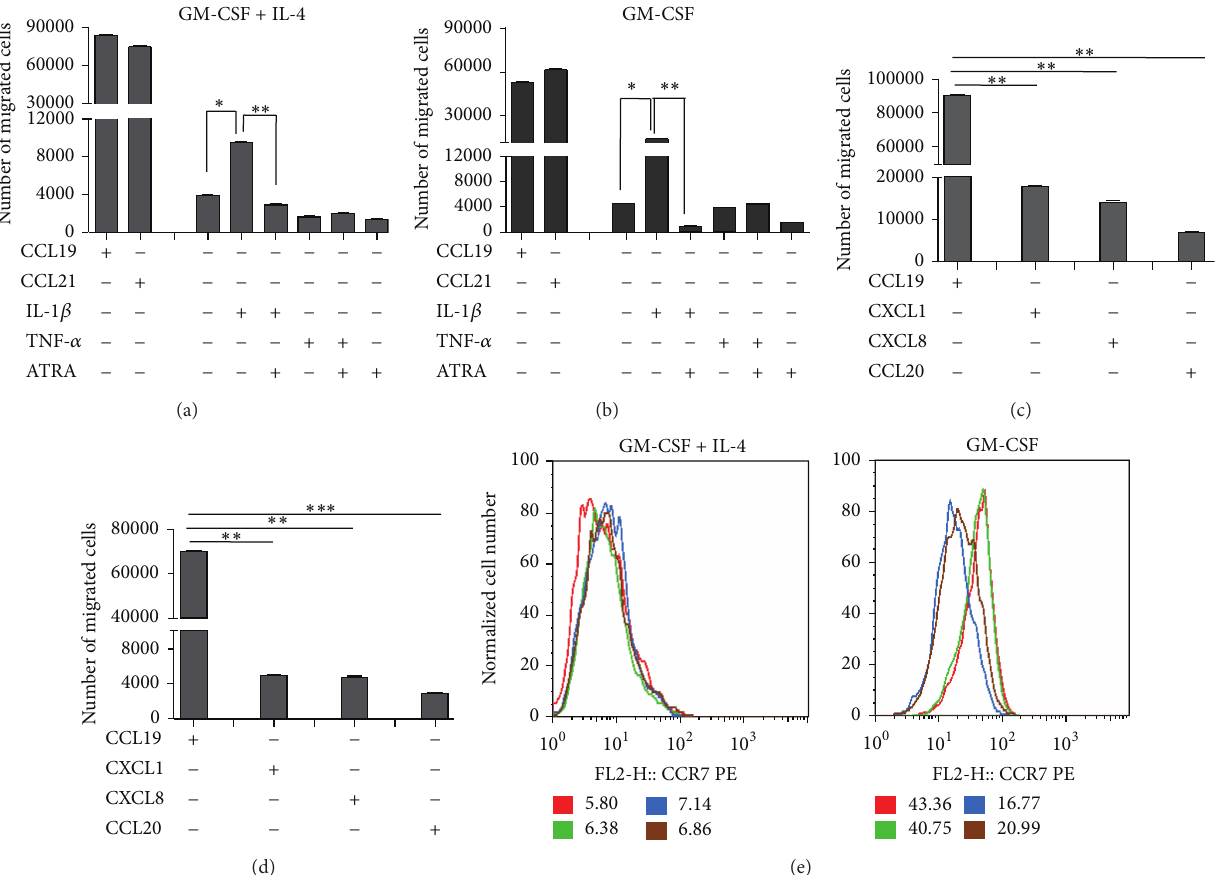
Figure 3: ATRA modifies the chemokine-dependent migration of in vitro differentiated myeloid cells. Caco2 cells were activated as described in Figure 1. The migratory potential of the monocyte-derived cells generated by GM-CSF+IL-4 or GM-CSF was tested in transwell chambers. 3 × 10 5 cells were placed on the upper chamber and the Caco2 cell supernatants on the lower chamber of the transwell plate. After 24 hr, the number of cells, which migrated to the lower chamber in response to the Caco2 cell supernatants, was counted by flow cytometry. The migratory potential of cells generated in the presence of GM-CSF+IL-4 (a) or GM-CSF (b) is shown as compared to the migratory potential of CCL19 and CCL21 chemokines, used as positive controls. To determine the cause of high migration in response to IL-1 𝛽 treated CEC supernatant, the GM-CSF+IL-4 (c) and GM-CSF (d) differentiated monocytes were treated with CXCL1, CXCL8, and CCL20 chemokines which were secreted exclusively by CEC on IL-1 𝛽 treatment. Bar diagrams indicate mean ± SD of 3 independent experiments ∗ 𝑃 < 0.05 , ∗∗ 𝑃 < 0.01 , and ∗∗∗ 𝑃 < 0.001 . Another fraction of monocyte-derived cells, differentiated by GM-CSF+IL-4 or GM-CSF, was also stimulated by the supernatant of IL-1 𝛽 pretreated CEC in the presence or absence of ATRA. The cell surface expression of CCR7 in the differentiated monocyte derived cells was measured by flow cytometry (e). Red line depicts untreated monocyte-derived cells, green is for monocyte-derived cells treated by the supernatant of Caco2 cells previously activated by IL-1 𝛽 , blue line is for monocyte-derived cells pretreated with the supernatant of Caco2 cells activated by IL-1 𝛽 and ATRA, and brown line corresponds to cells treated by the supernatant of unstimulated Caco2 cells in combination with ATRA. Results of 3 independent experiments are shown as mean ± SD of